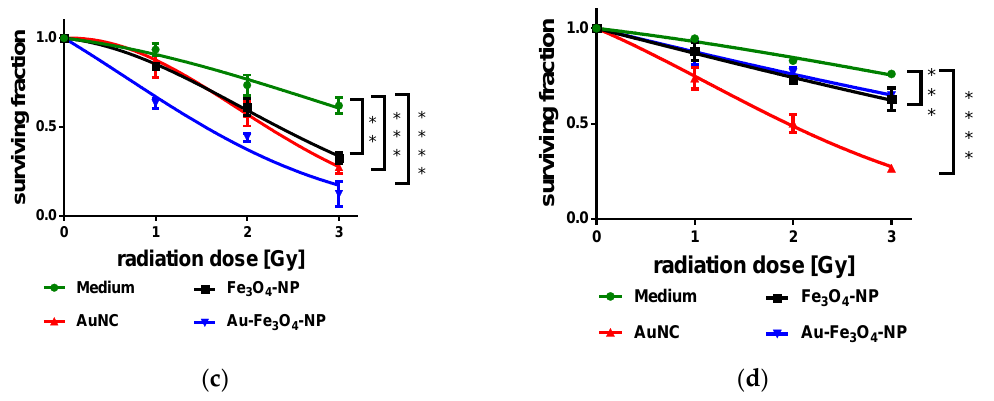
Figure 11. ( a ) Reaction scheme of the Fe 2+ /Fe 3+ -catalyzed Fenton reaction and Haber-Weiss cycle; radiation dose survival curves of MCF-7 cells ( b ), A549 cell ( c ) and MCF-10A cells ( d ) in medium (green) and incubated with Fe 3 O 4 @Au pNPs (blue), Fe 3 O 4 NPs (black) and AuNC (red).